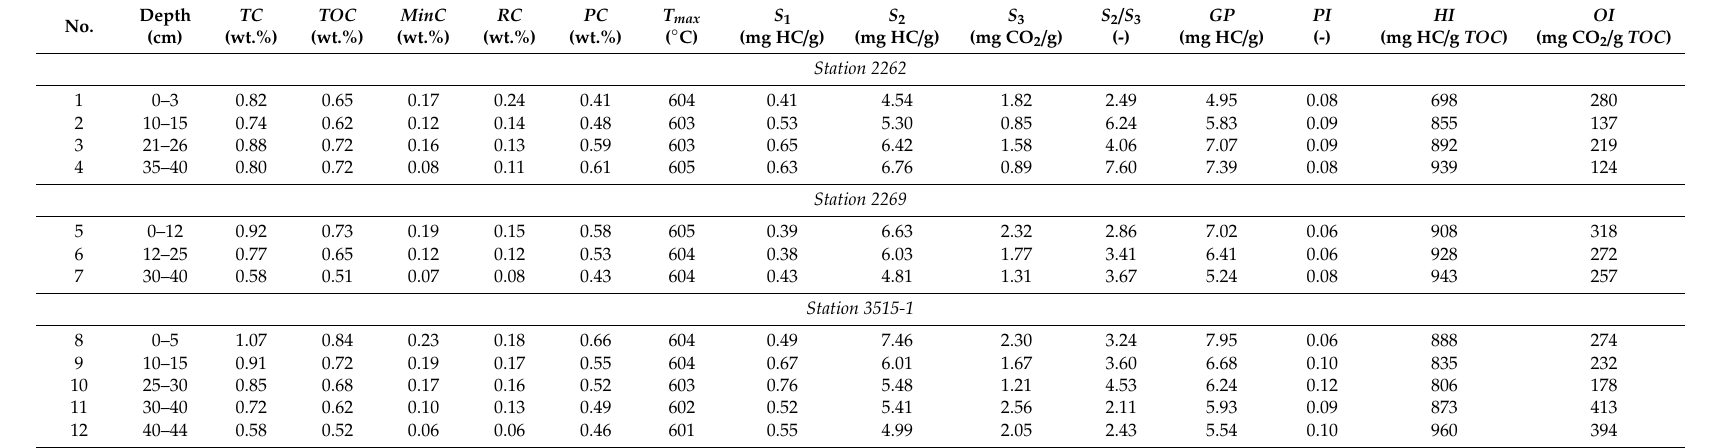
Table 3. Selected measured parameters and calculated indices of R–E6 ( n =